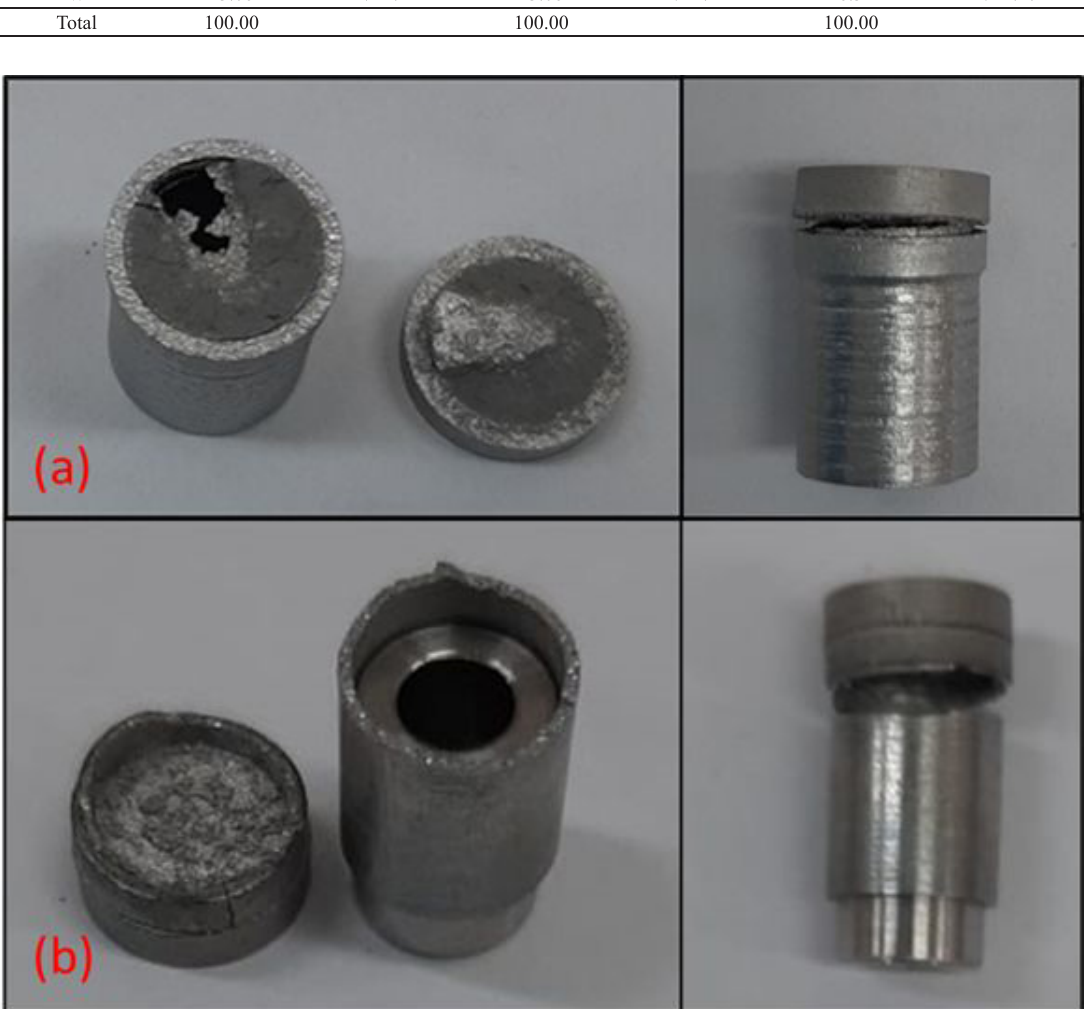
Figure 15. (a) cathode sample 1 after strength test, and (b) cathode sample 3 after strength